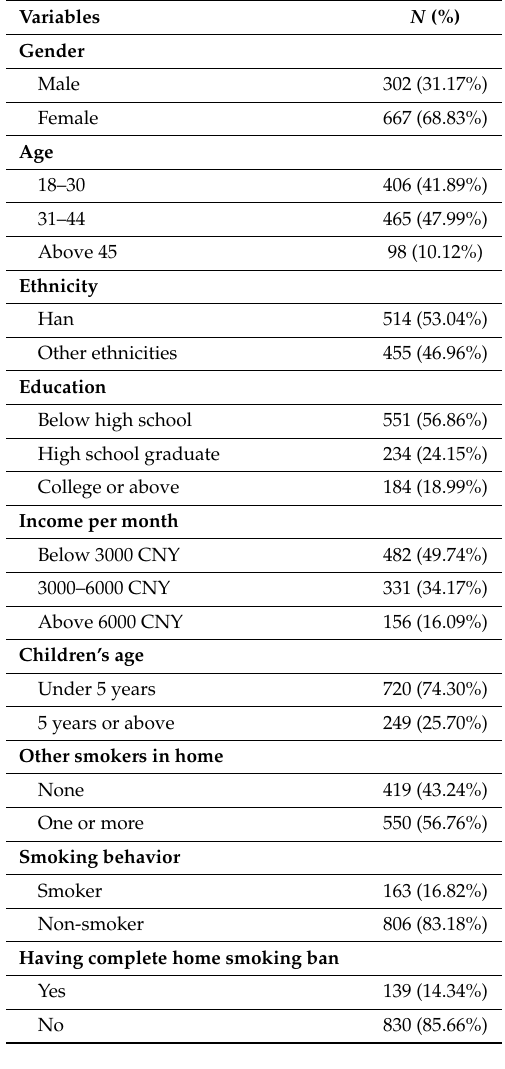
Table 1. Characteristics of participating parents ( N =